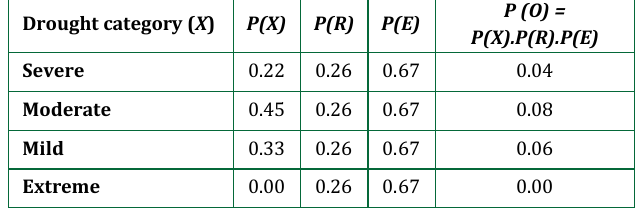
Table 4: Probable characteristics of future agricultural droughts that